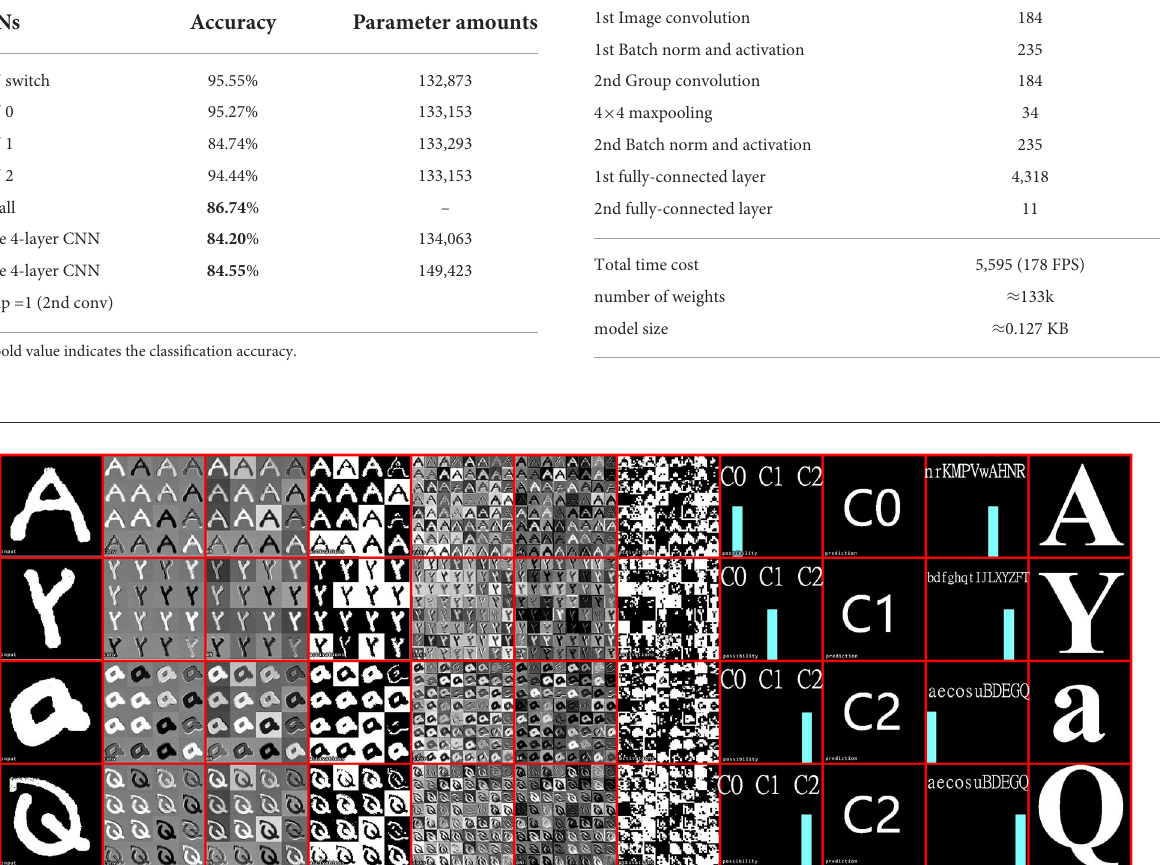
TABLE 1 Convolutional neural network (CNN) classification accuracy among different CNNs.